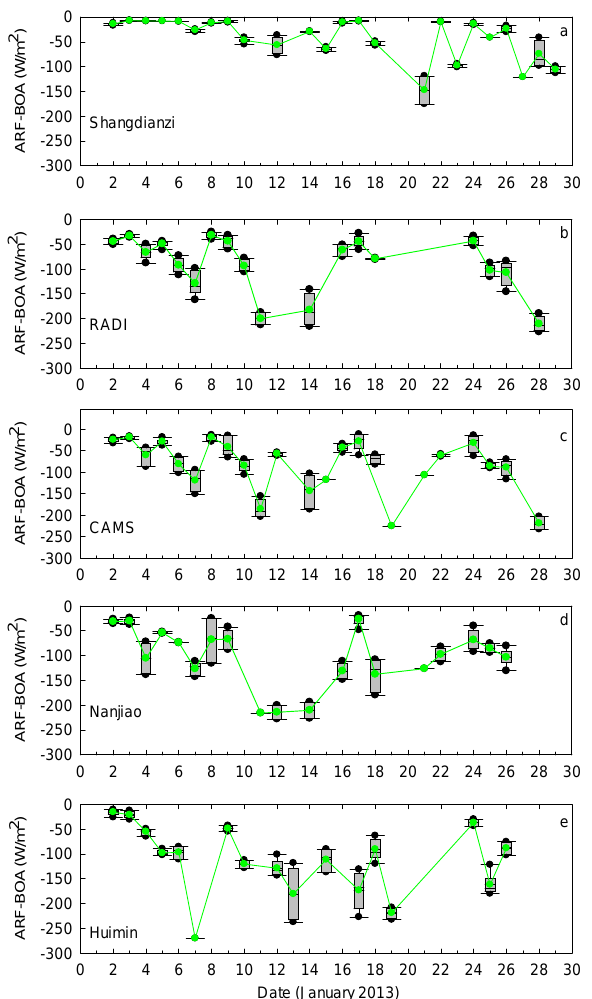
Fig. 8. Aerosol radiative forcing at the surface (ARF-BOA) and its 5th and 95th percentile box plots during January 2013 at five sites in North China Plain.